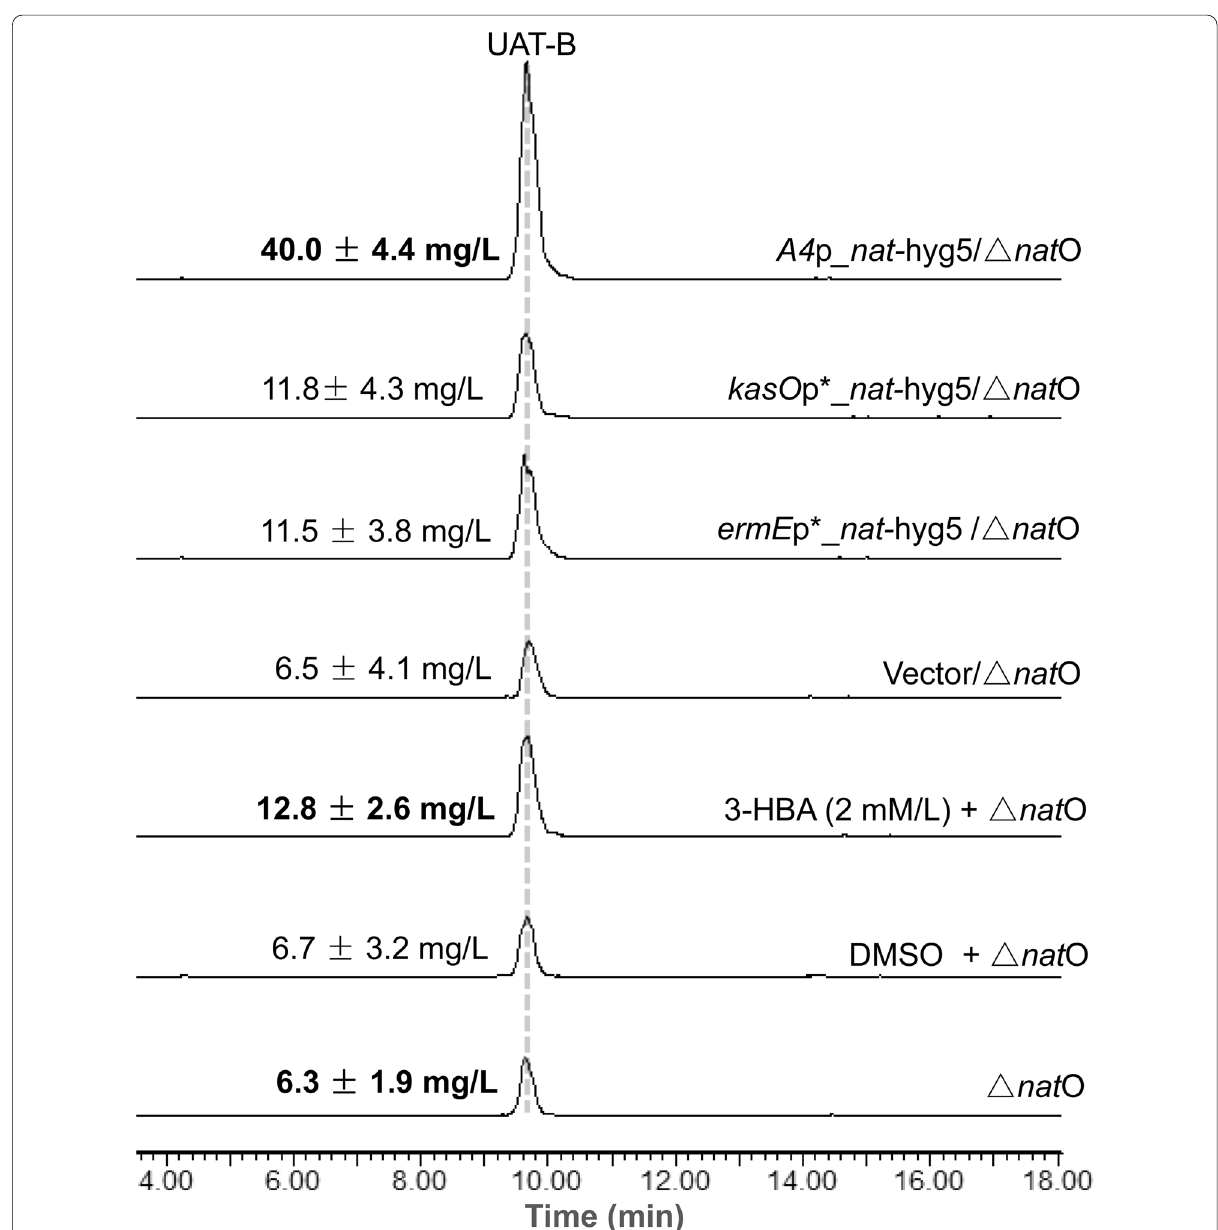
Fig. 3 HPLC–MS analysis of UAT‑B production in the fermentation extracts of the Δ nat O strain fed 3‑HBA or containing different nat ‑hyg3 gene expression cassettes: A4 p _nat- hyg5, kasO p*_ nat- hyg5 or ermE p*_ nat- hyg5. The HPLC–MS data are displayed with the mass extraction of [M m / z 676.4 for UAT‑B. The exact UAT‑B production titres displayed were obtained by using UPLC‑QqQ/MS analysis. All the production titre values shown are the mean standard deviation of triplicate ±